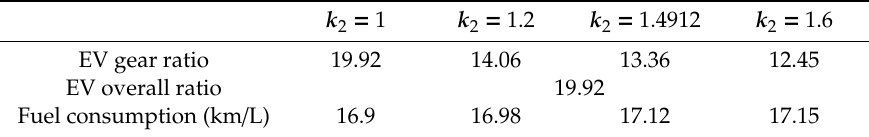
Figure 12. ( a ) Standard extra-urban driving cycle (EUDC) driving cycle. ( b ) Simulation follow driving cycle. ( c ) Status of engine. ( d ) State of motor ( 𝑘 2 = 1 ). Table 6. Fuel consumption under extra-urban driving cycle (EUDC).